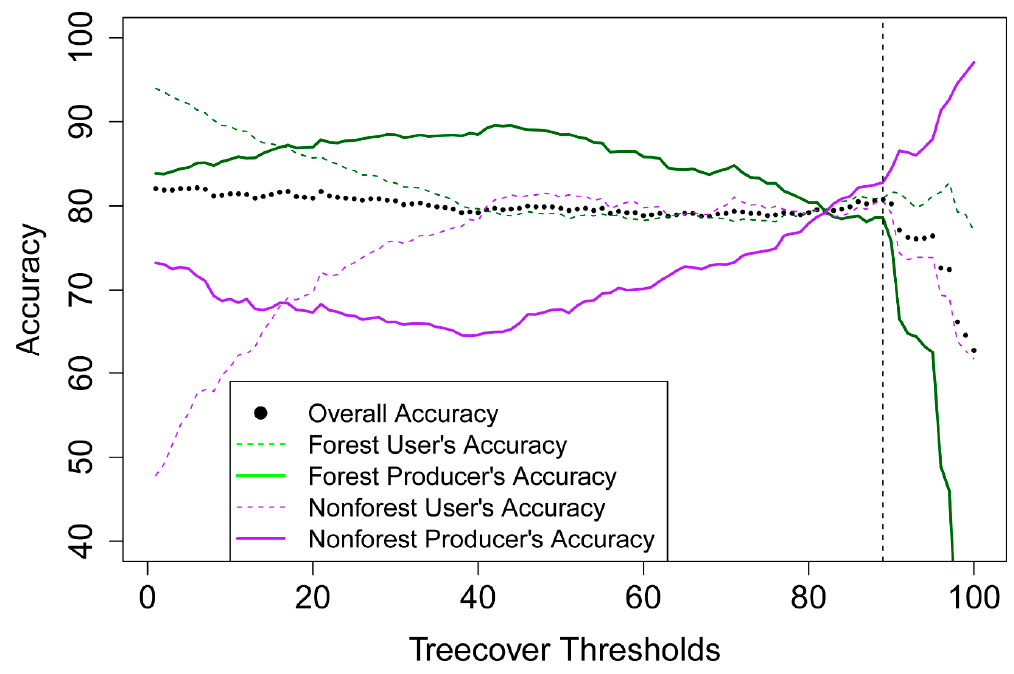
Figure 2. Tree cover accuracy at varying thresholds for the GFC product. The solid vertical line indicates the intersection of the commission and omission errors for both the forest and non-forest classes.